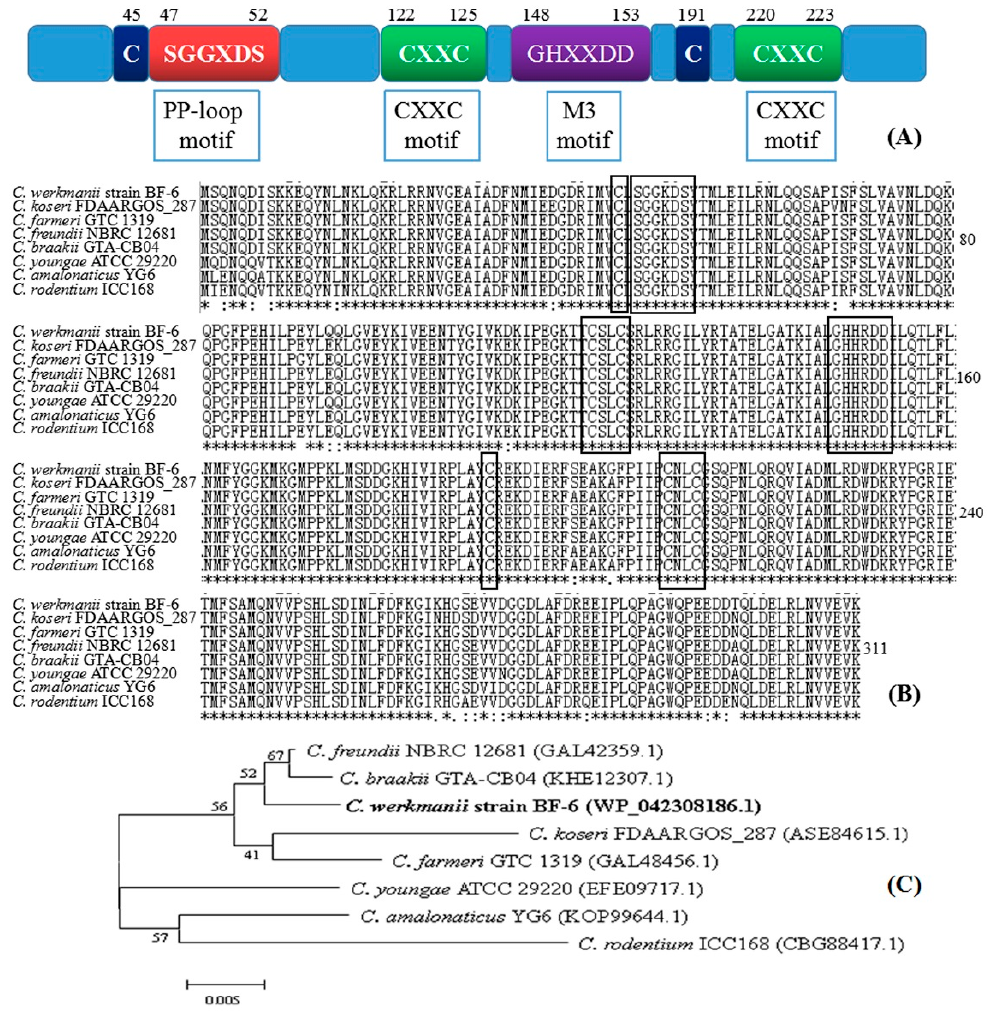
Figure 1. Screening of random resistant mutants using a LB plate supplemented with 32 mg/L BIT ( A ) and identification of Δ ttcA and Δ ttcA -com through PCR ( B ). Lane 1: C. werkmanii BF-6 (Control); Lane 2: Δ ttcA ; Lane 3: Δ ttcA -com.